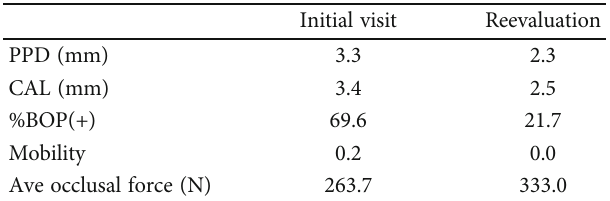
Table 1: Comparison of periodontal tissue and occlusal force at the initial visit and